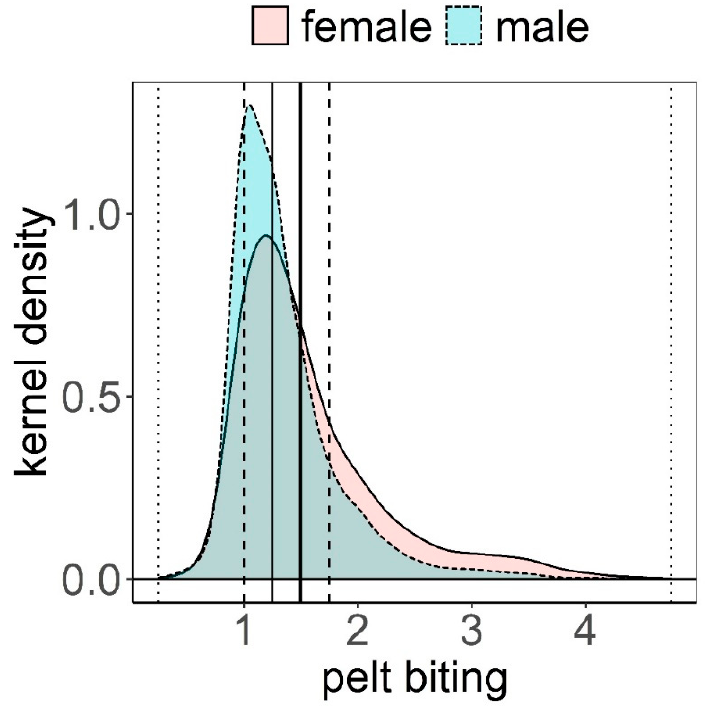
Figure 2. Kernel density estimation of pelt biting classes within female (f) and male (m) deer (see Methods for a definition of the classes). Mean (vertical solid thick line), median (vertical solid thin line), 1st and 3rd quartiles (vertical dashed lines), minimum and maximum (vertical dotted lines).